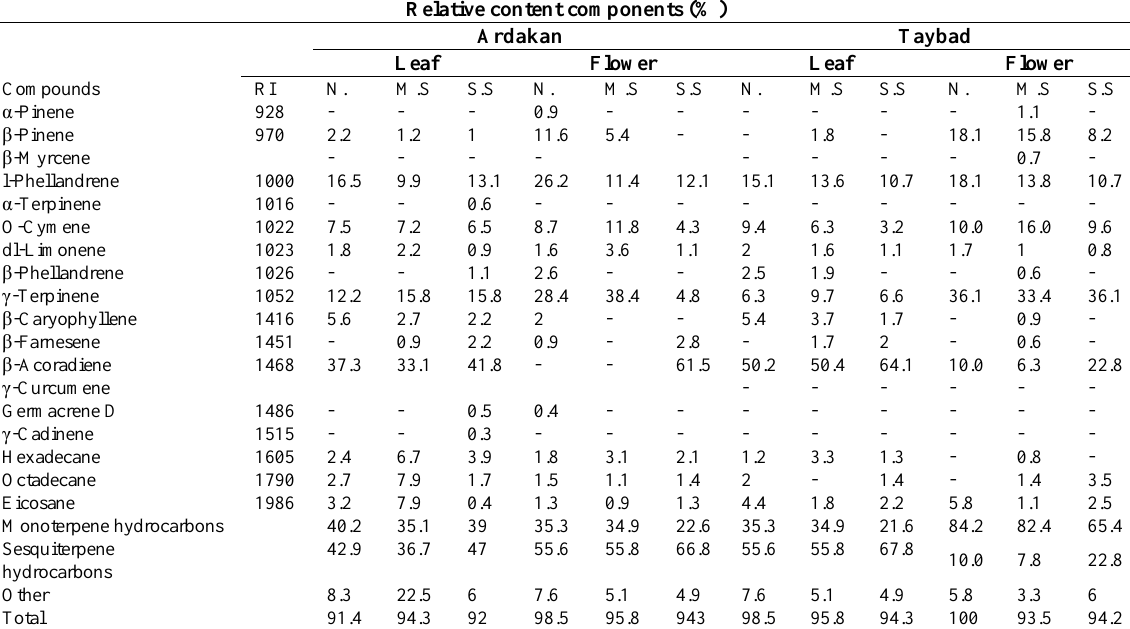
Table 3. Chemical composition of leaf and flower tissues of two ecotypes under drought